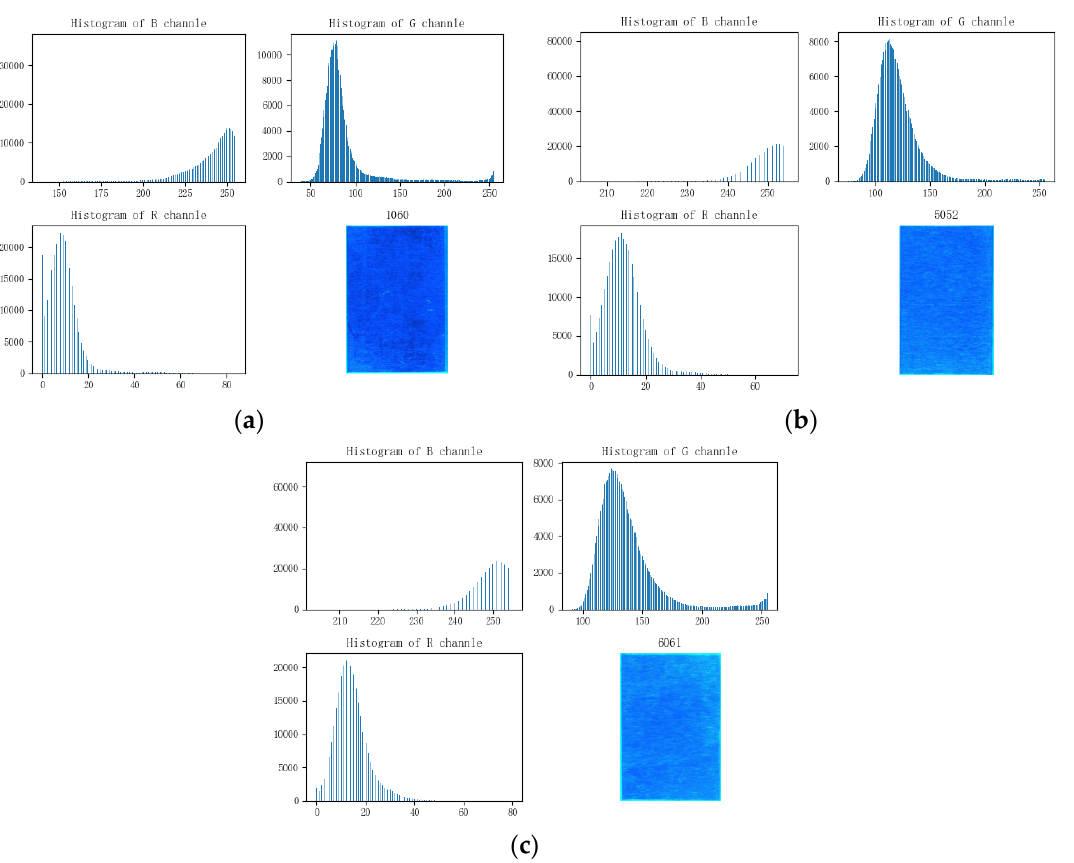
Figure 10. RGB color channel histograms: ( a ) 1060, ( b ) 5052, ( c ) 6061. Specifically analyzing the differences between the R, B, and G color channels, the histograms show that in the R channel, the extreme values of 1060 and 6061 are both greater than 20,000, significantly higher than that of 5052, with 1060 slightly higher than 6061; in the B channel, the extreme values of 5052 and 6061 were both greater than 20,000, much greater than that of 1060, and the slopes of 5052 and 6061 were steeper while that of 1060 was relatively gentle; in the G channel, the extreme value of 1060 was larger than those of 5052 and 6061, and the extreme brightness of 1060 was near 75, while the extreme brightnesses of 5052 and 6061 were in the ranges of 110–114 and 124–126, respectively, with a clear demarcation